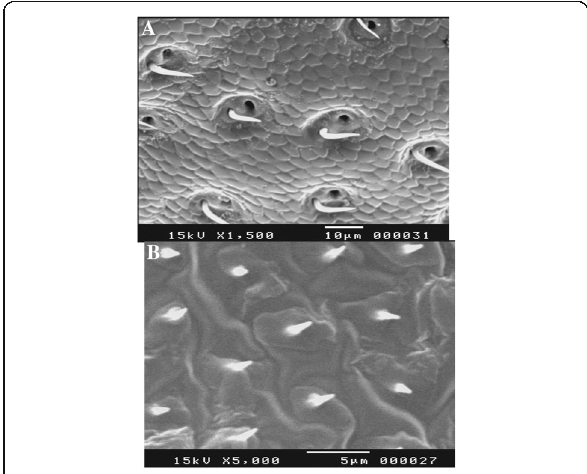
Fig. 13 a Higher magnification of the elytra showing the seta with large pore close to the margin of each pit. b SEM of upper surface of the hind wing membrane of T. confusum contains numerous